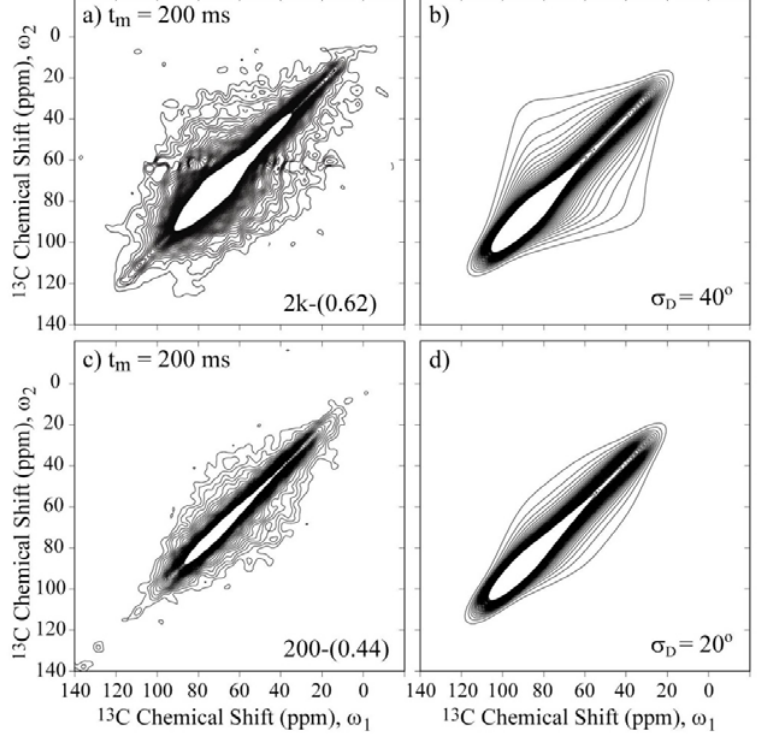
Figure 7. Experimental and simulated 2D Exchange spectra for the ( a ),( b ) 2k-(0.62) sample at T = − 20 °C and the ( c ),( d ) 200-(0.44) sample at T = 10 °C. The simulations